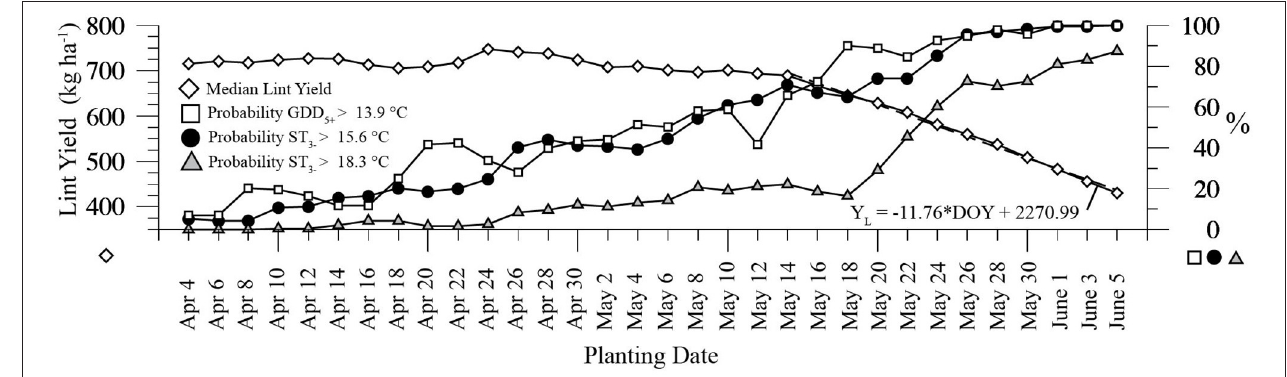
FIGURE 7 | Diamonds mark the medians of the Figure 6A lint yield distributions. Gray triangles show the probability that minimum daily soil temperatures at 10cm in the 3 days before each planting date (ST 3 − ) exceeds 18.3 ◦ C. Black circles show similar probabilities based on a 15.6 ◦ C ST 3 − threshold. Squares show the probability that cotton growing degree totals over the 5 day period after each planting date (GDD 5 + ) exceeds 13.9 ◦